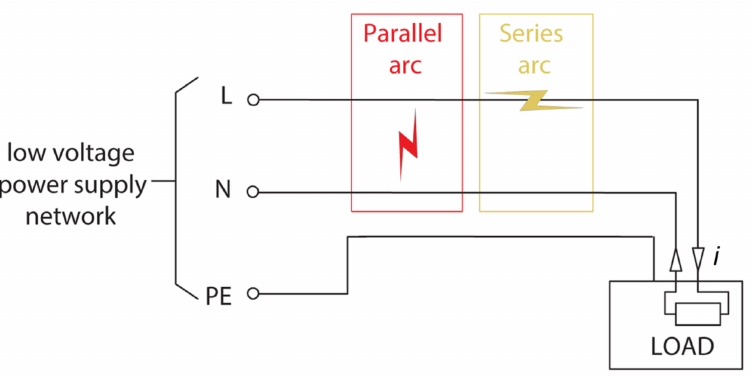
Figure 1. Parallel and series arc fault, L: Live, N: neutral, PE: